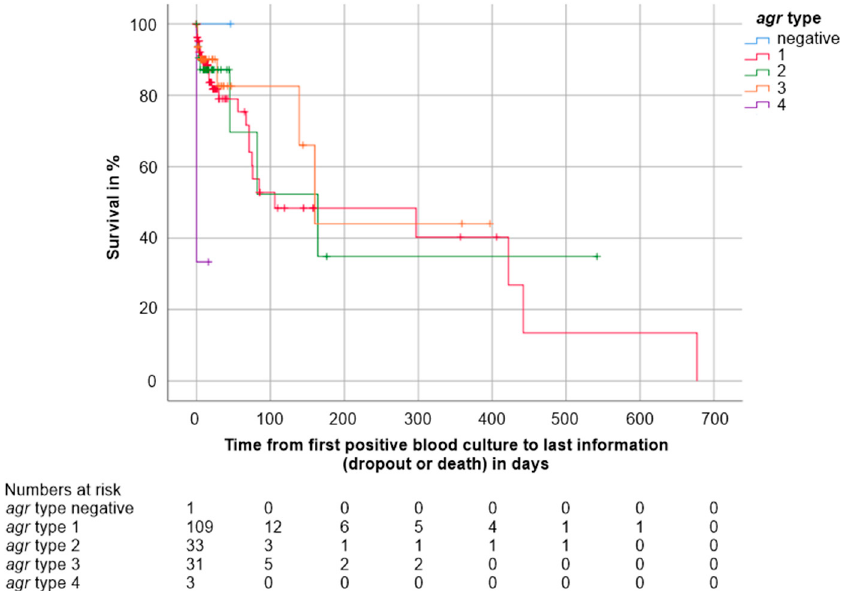
Figure 5. Kaplan Meier survival estimates distinguished by agr type: negative ( n = 1, 0 deaths), agr type 1 ( n = 109, 28 deaths), agr type 2 ( n = 33, 7 deaths), agr type 3 ( n = 31, 6 deaths) and agr type 4 ( n = 3, 2 deaths). The numbers of patients under observation per agr type at each time point are given